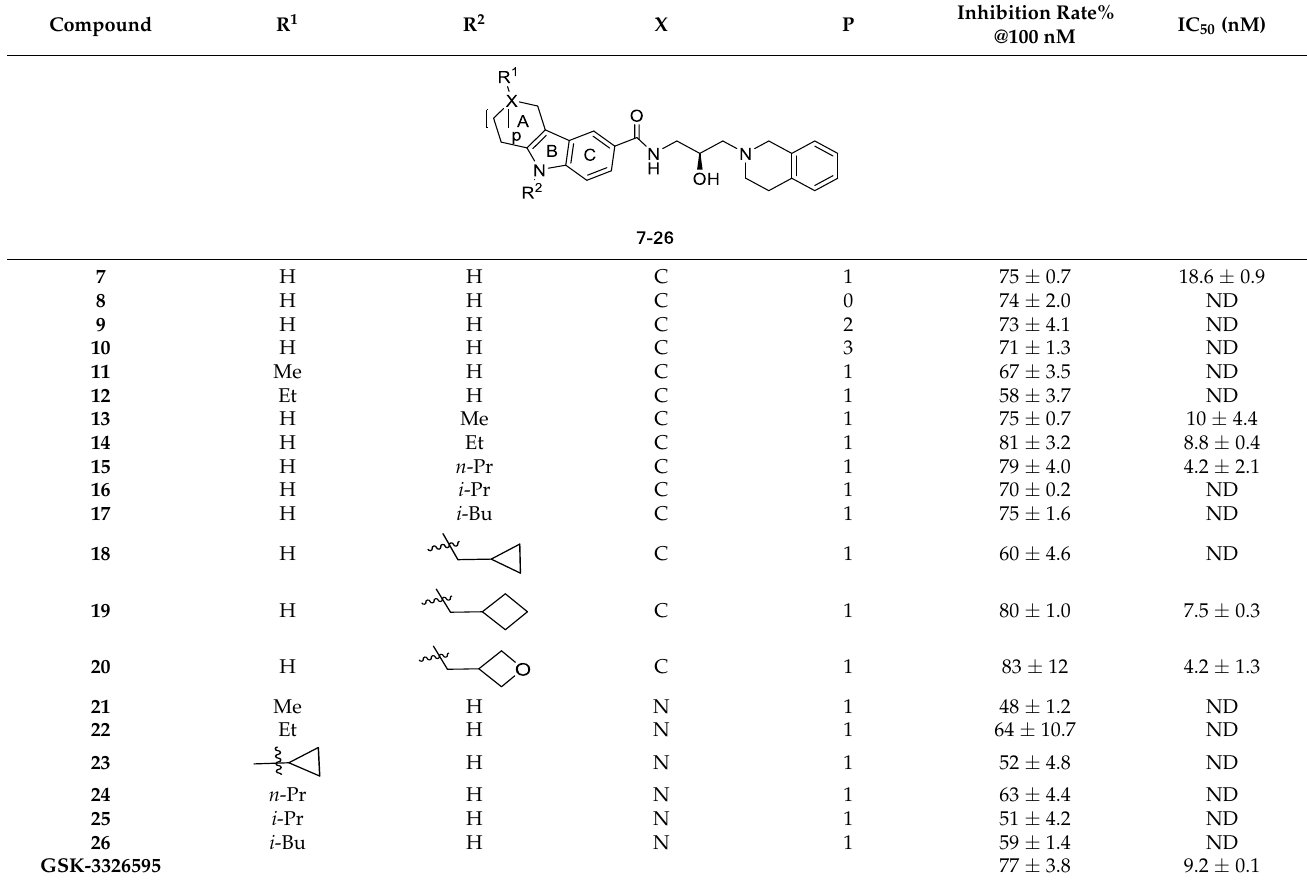
Table 2. In Vitro PRMT5 Inhibitory activity of compounds 7~26. Compound